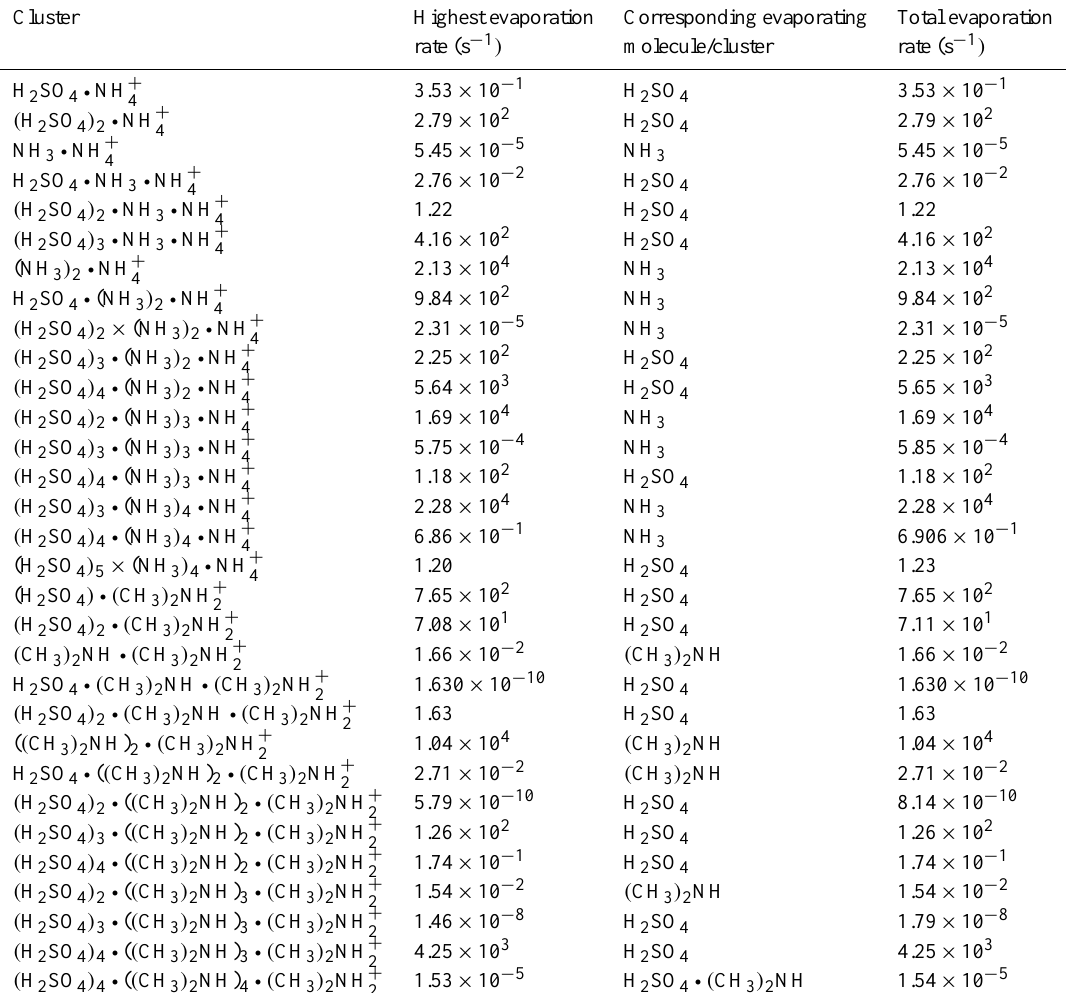
Table 2. Highest evaporation rate, corresponding evaporating molecule/cluster and total evaporation rate at 298.15K for different positively charged clusters